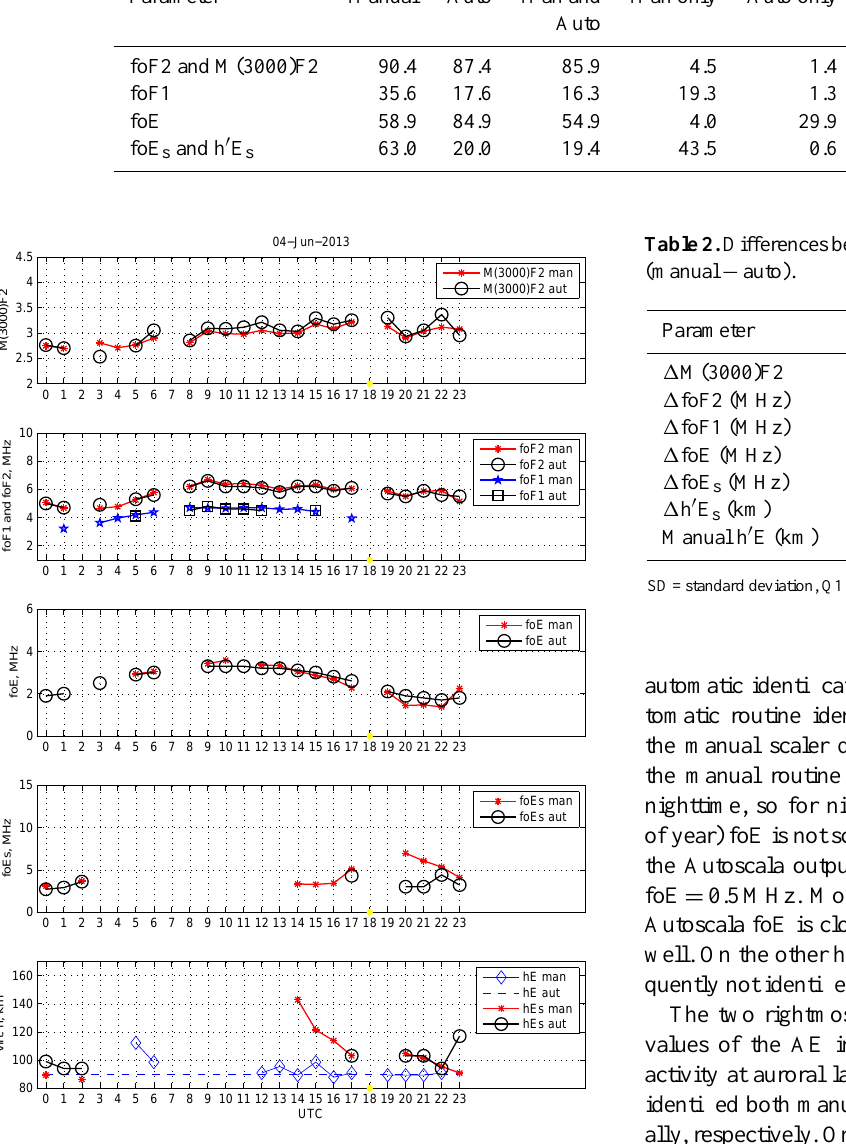
Figure 3. Comparison of manually and automatically scaled param- eters for 4 June 2013. Panel 1: M(3000)F2, panel 2: F-layer O-mode critical frequencies, panel 3: foE, panel 4: foE s and panel 5: E-layer virtual heights. Autoscala always assumes the lower edge of the E layer at 90km (dashed line). The yellow dot on the time axis indi- cates a time (18:00UT) when the ionosonde was not operating.